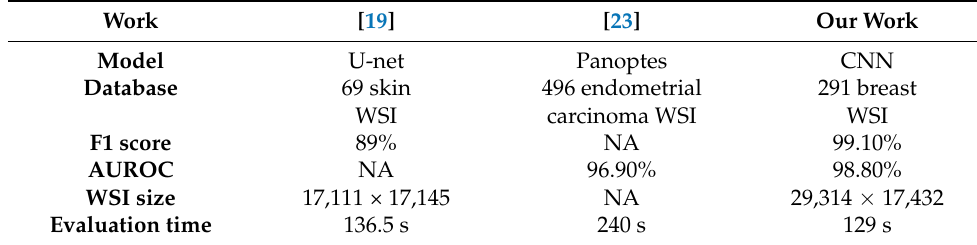
Table 4. Comparing our approach to the other WSI segmentation techniques that consider the time factor as